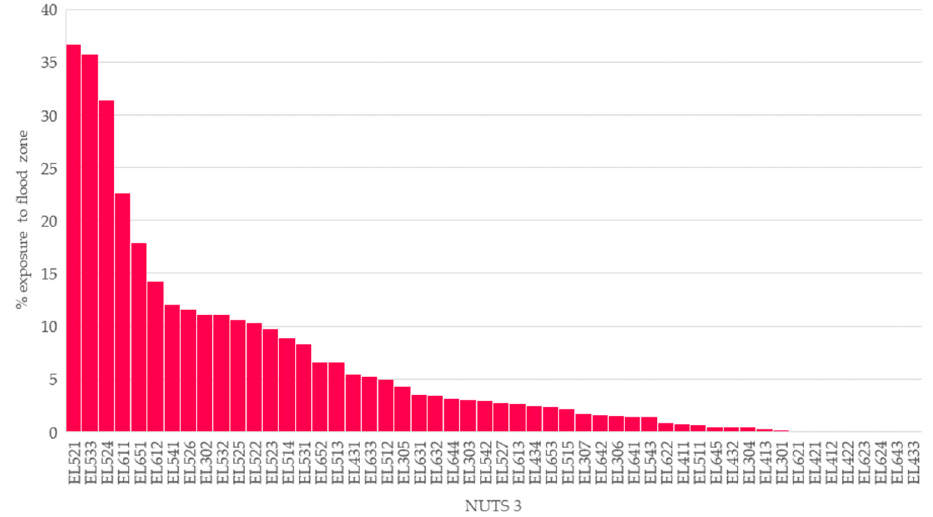
Figure 11. Graphical representation of the ratio of the urban fabric in flood zones per NUTS 3 in descending order.